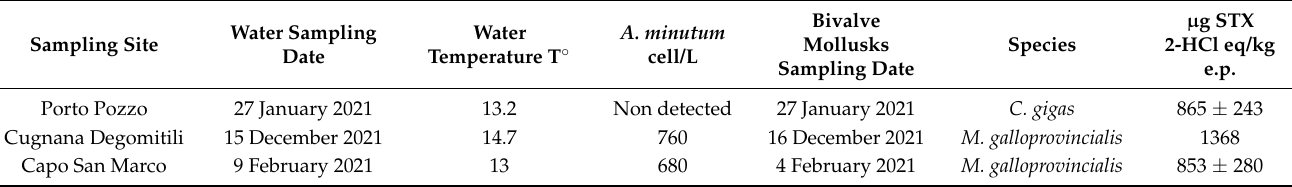
Table 2. Samples that exceeded the limits of PSP.